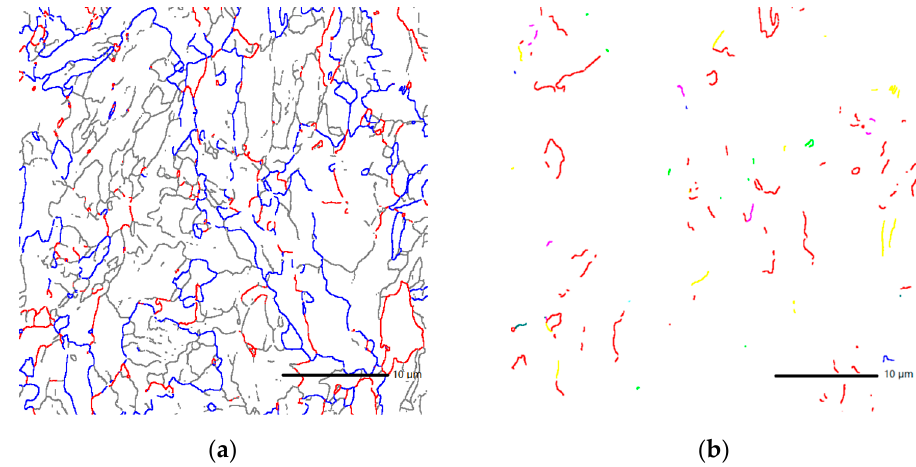
Figure 3. ( a ) The grain boundaries of 0–15°, 15°–45°, and greater than 45° are shown in the gray, red, and blue lines, and ( b ) Σ 3, Σ 11 CSL of the X70 steel are shown in the red and yellow lines.